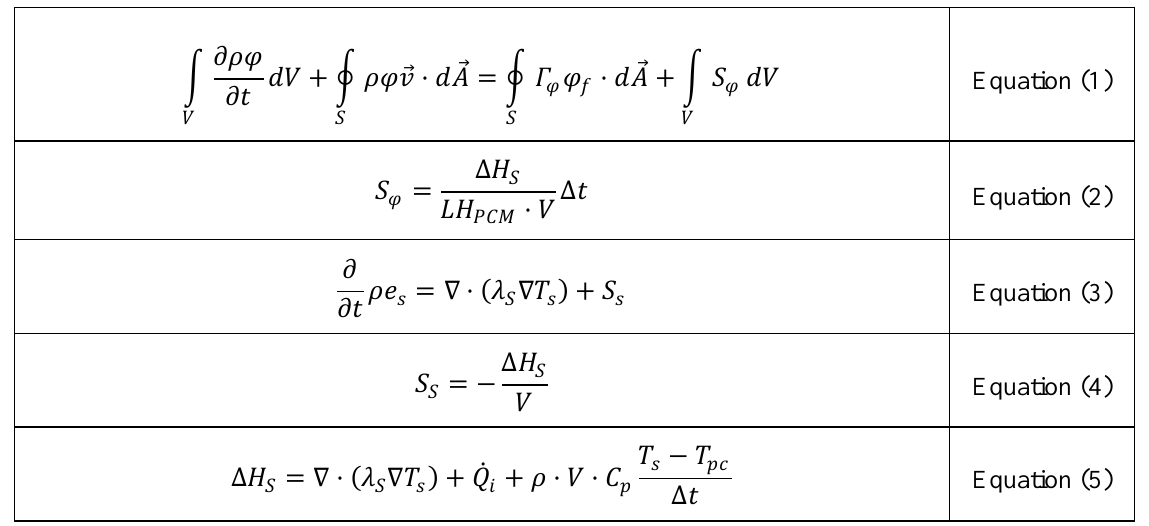
Table 2. Equations of the PCM